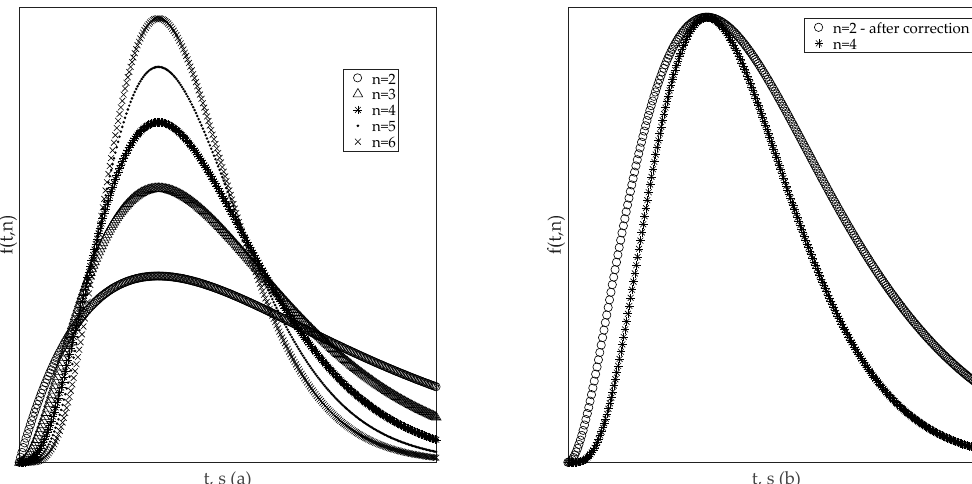
(cid:16) (cid:17) n T hpf · s + h ( a ), and impulse characteristics